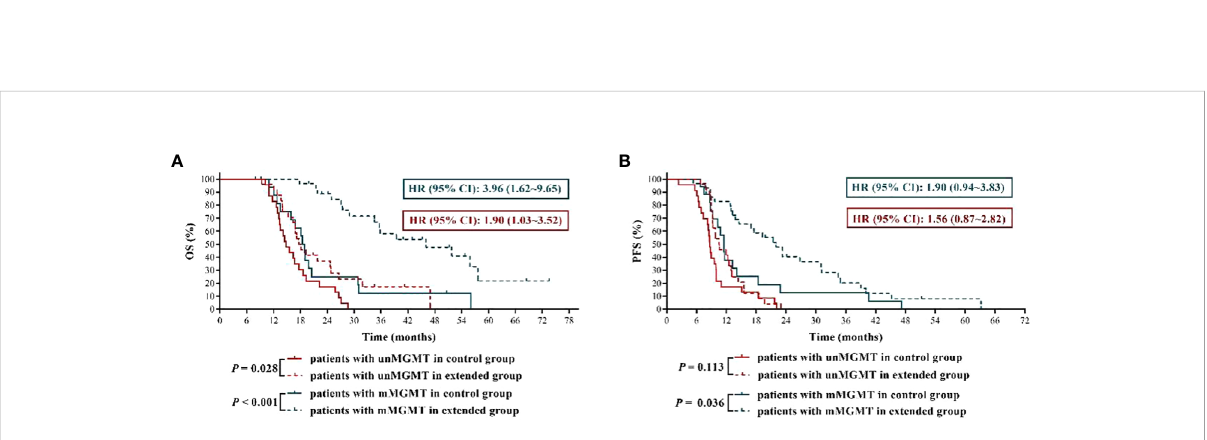
FIGURE 3 The effects of extended adjuvant temozolomide chemotherapy on the clinical outcomes of newly diagnosed glioblastoma patients with different O6-methylguanine DNA methyltransferase promoter methylation statuses. (A) The Kaplan − Meier survival curves for overall survival. (B) The Kaplan − Meier survival curves for progression-free